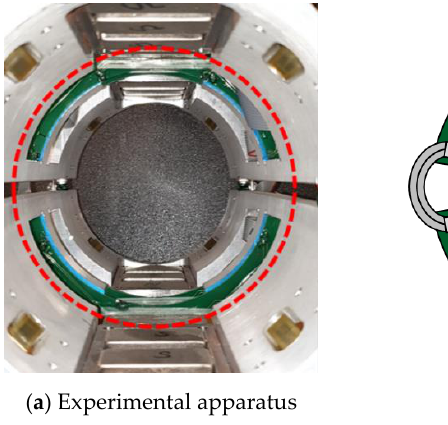
Figure 12. Array of the Hall-effect sensors.